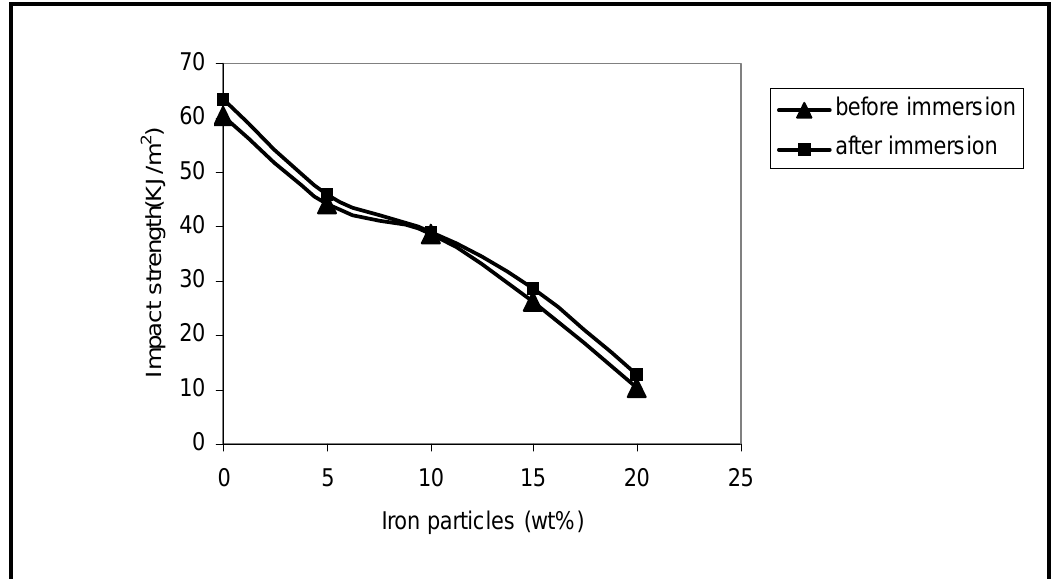
Fig. 2: Impact strength (KJ/m 2 ) values as a function of Iron particles (wt%).